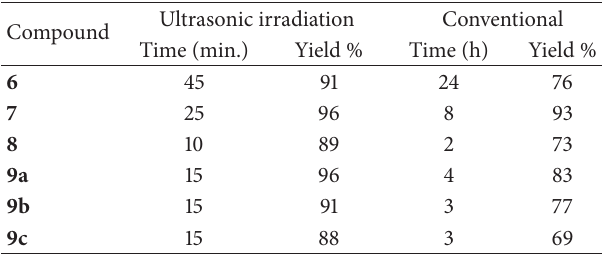
Table 2: Synthesis of 1,3,4-oxadiazole 6 , 1,3,4-thiadiazole 8 , and 1,2,4-triazole 9a–c derivatives under ultrasonic irradiation and conventional method.